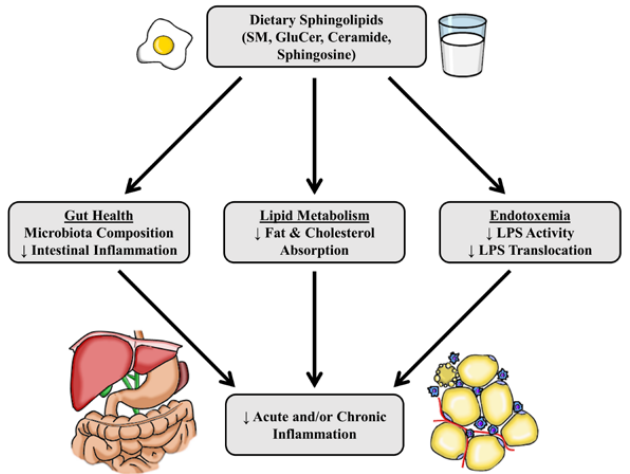
Figure 2. Potential effects of dietary sphingolipids relevant to acute and/or chronic inflammation. Abbreviations: GluCer, glucosylceramide; LPS, lipopolysaccharide; SM, sphingomyelin; ↑ , increase; ↓